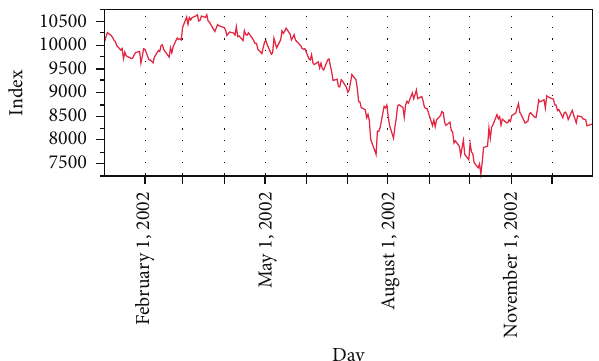
Figure 2: Unprocessed data for year 2002 of DJI.